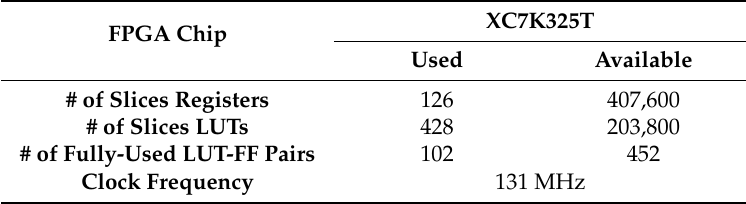
Table 3. Characteristics of proposed architecture implemented in